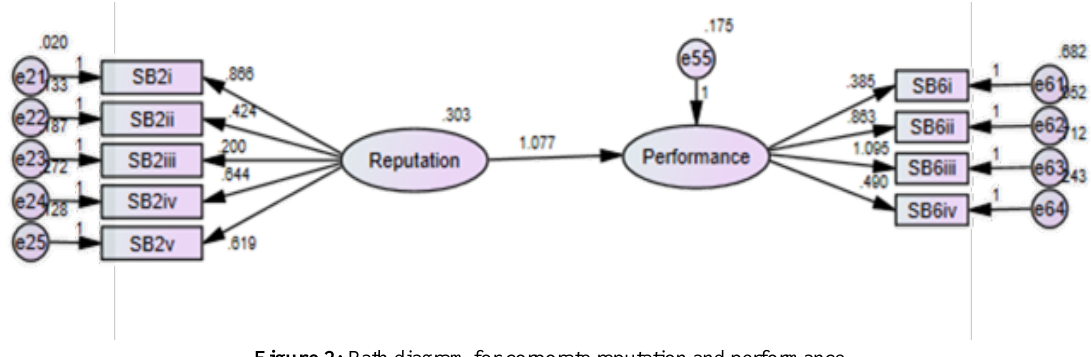
Figure 2: Path diagram for corporate reputation and performance